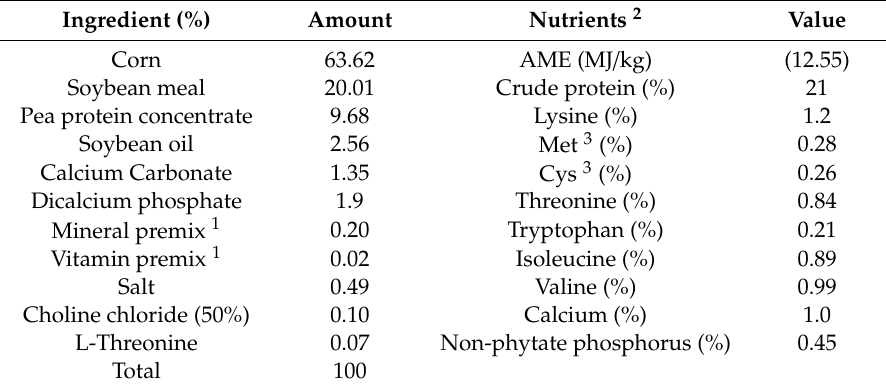
Table 1. Composition of the basal diet (air-dry basis,